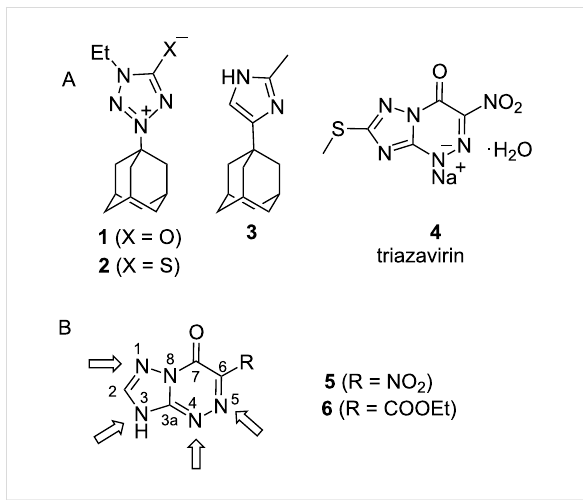
Figure 1: (A) Adamantylated azoles and derivatives of 1,2,4- triazolo[5,1- c ][1,2,4]triazine with antiviral activities. (B) Four sites sensi- tive to N-alkylation in 1,2,4-triazolo[5,1- c ][1,2,4]triazin-7-ones are indi- cated by